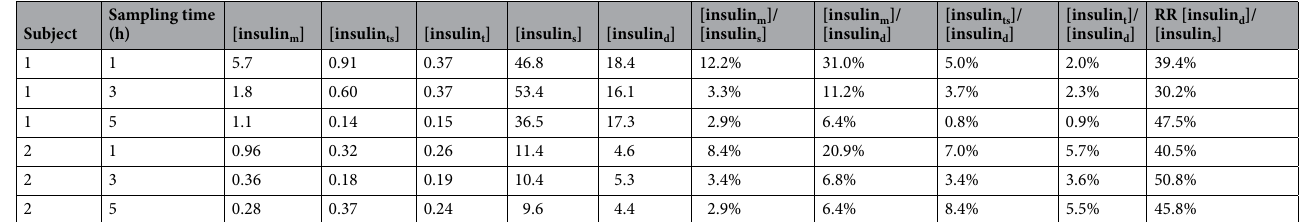
Table 3. Concentration of insulin (mU/L) adsorbed to the microdialysis membrane (insulin m ), tubing descended in serum (insulin ts ), tubing not descended in serum (insulin t ), dialysate (insulin d ) and control samples from the serum bath after sampling (insulin s ) in vitro. RR = relative recovery. Insulin concentration analyzed using ELISA.